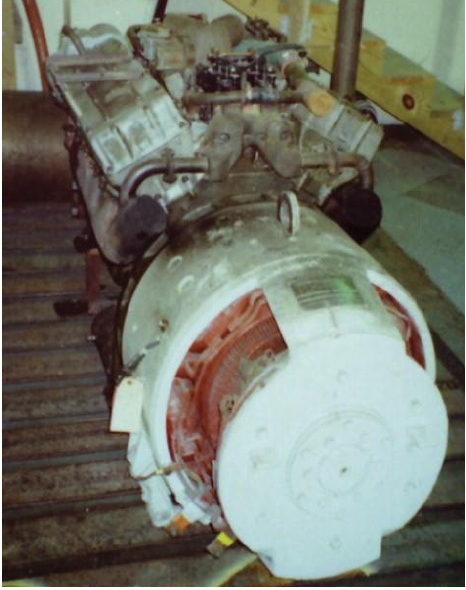
Fig. 10. The Ford GAA engine driving the alternator (photo by the author)